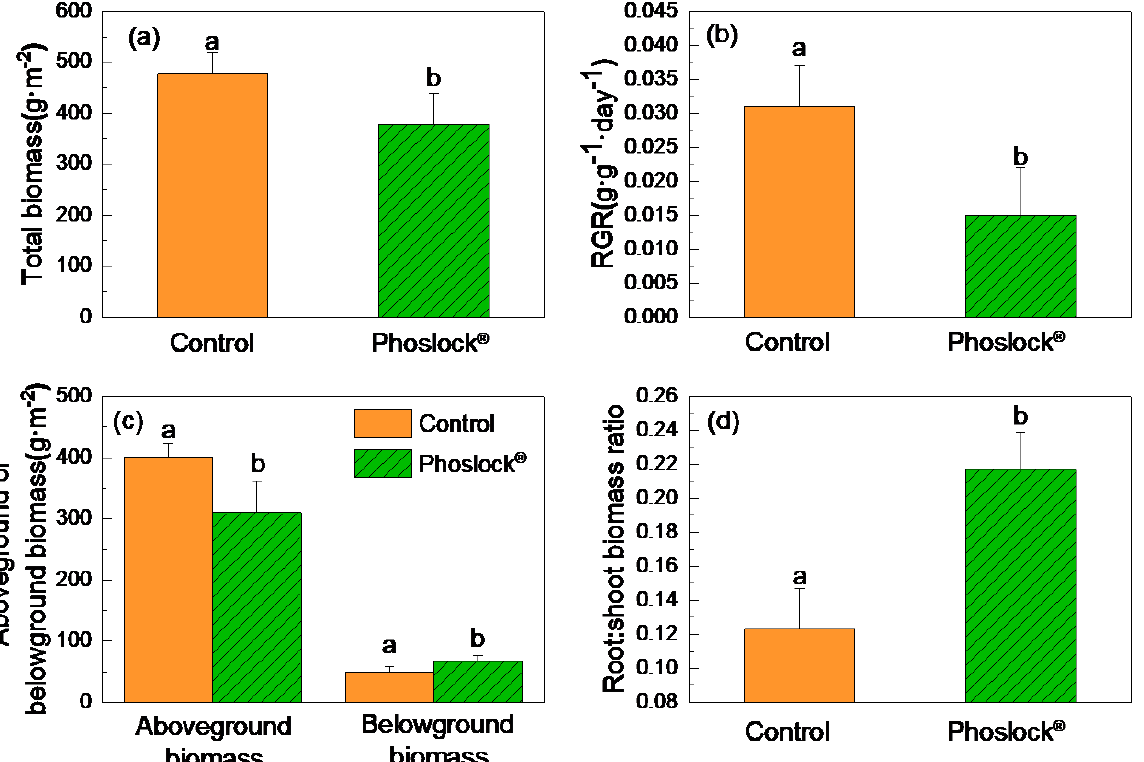
Figure 2. The differences in the total biomass ( a ), relative growth rate ( b ), aboveground and belowground biomass ( c ) and root: shoot biomass ratio ( d ) of Myriolhyllum spicatum in the control (without Phoslock ® addition) and Phoslock ® (with Phoslock ® addition) treatments at the end of experiment. Different letters indicate a significant difference among treatments at p < 0.05. Error bars represent the standard deviations (SD).